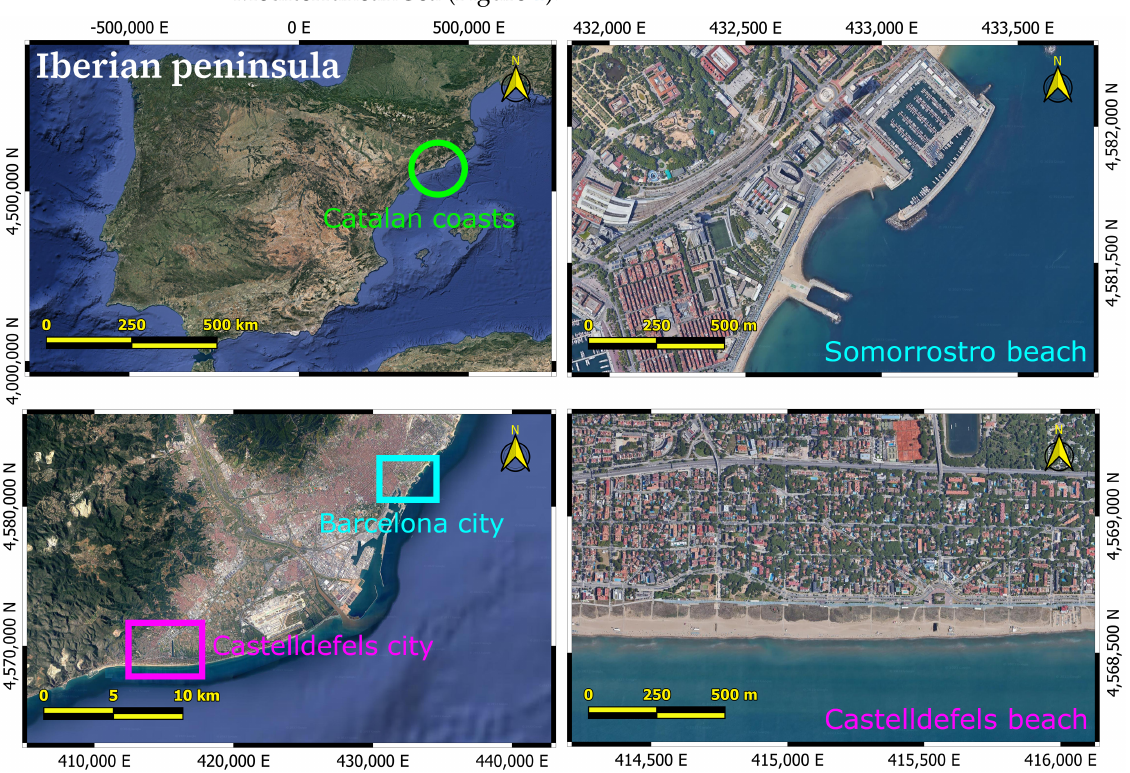
Figure 1. Geographical location of the studied beaches in Castelldefels and Barcelona cities (Spain) Source: Google maps, images from TerraMetrics, CNES/Airbus, Institut Cartogràfic de Catalunya, Landsat/Copernicus, Maxar